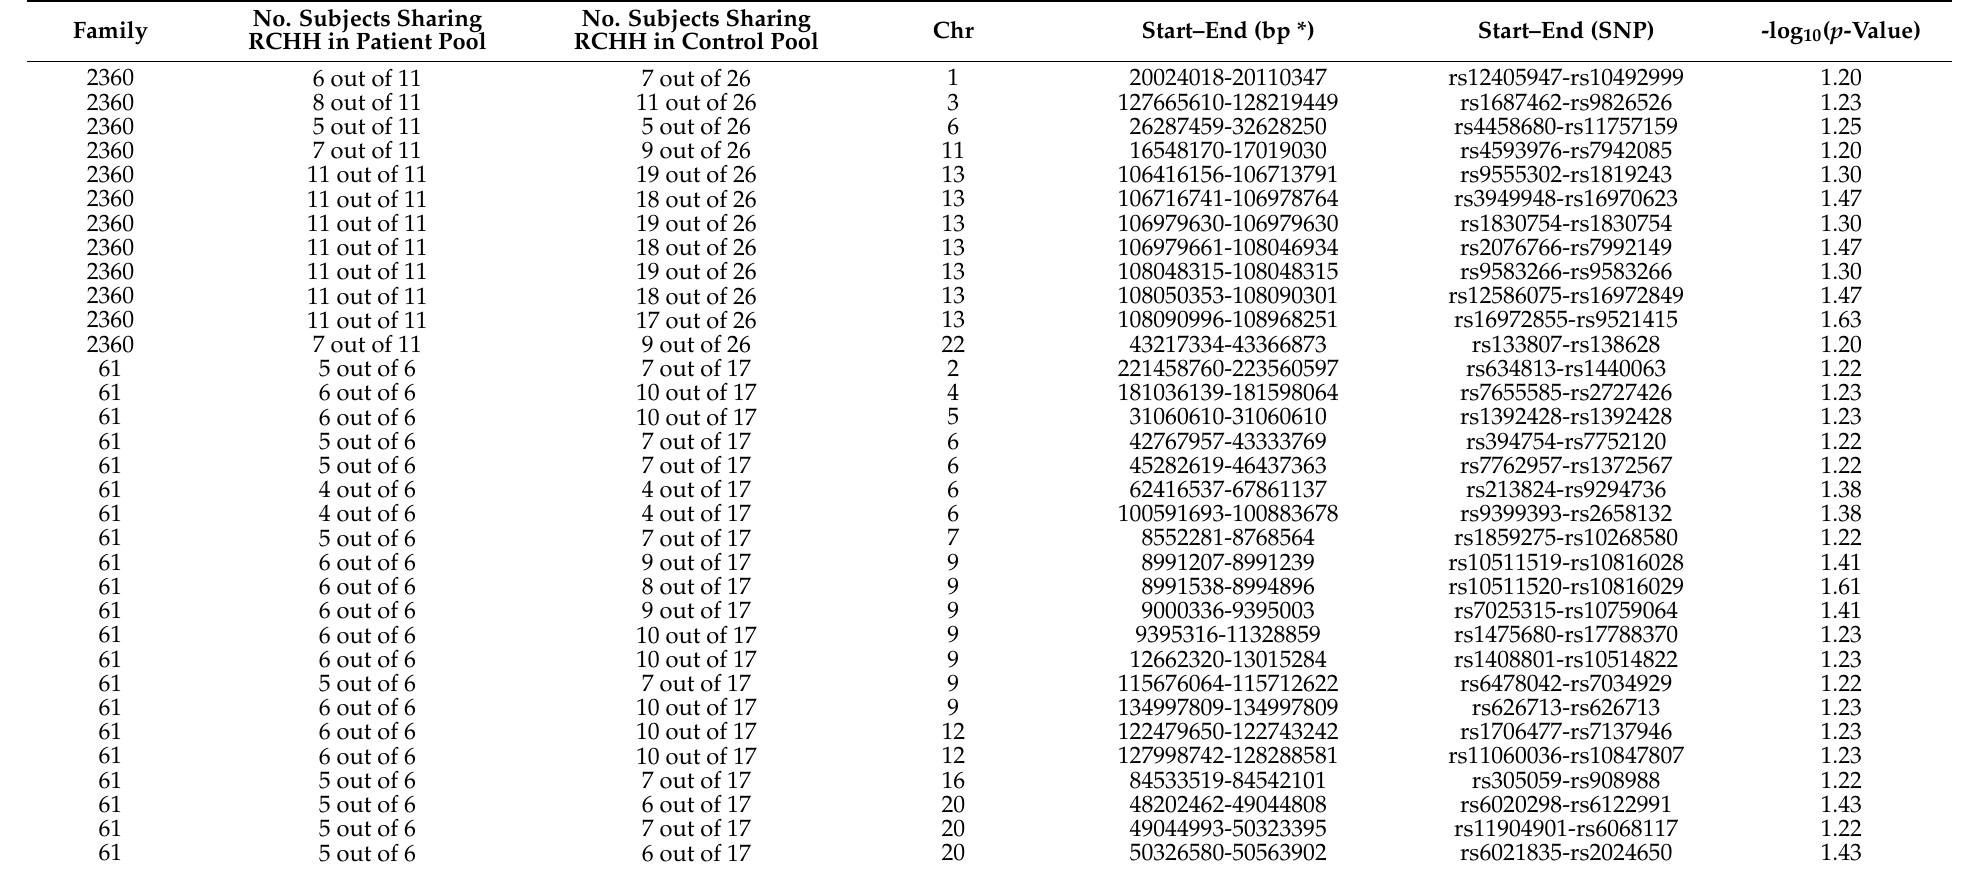
Table 2. List of RCHHs grouped by family. The table reports the number of subjects sharing an RCHH in both pools, its coordinate and the -log 10 ( p -value) for the difference between the pools. In our study, we set a significance level of -log 10 ( p -value) ≥ 1.2, corresponding to a p -value of